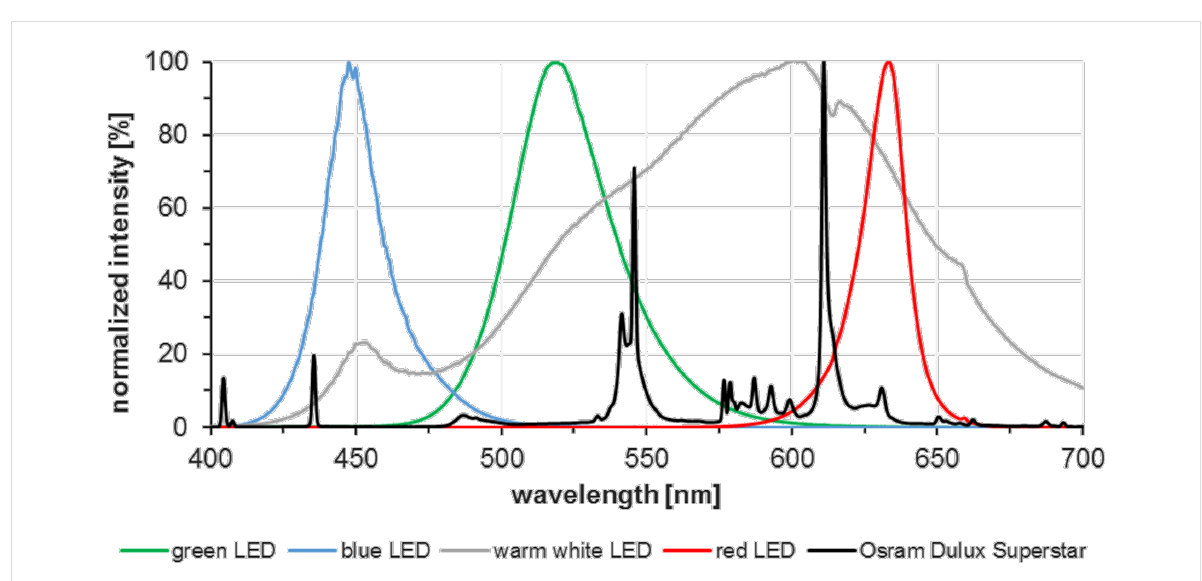
Figure 5: Emission spectra of different LEDs; red ( λ max = 633 nm), blue ( λ max = 448 nm), green ( λ max = 520 nm), warm white ( λ max = 600 nm), and Osram Dulux